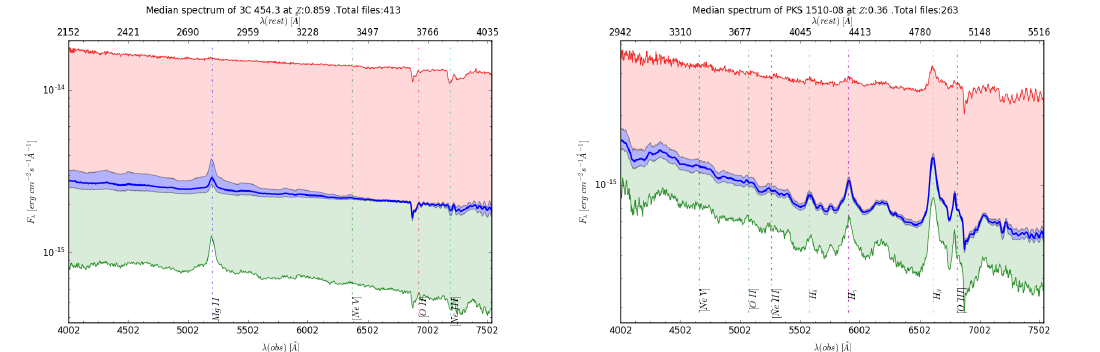
Figure 1. Median spectra computed for two FSRQ type objects: 3C 454.3 and PKS 1510-08. The median spectrum is shown as the dark blue line, red and green lines represent the spectra at the maximum and minimum levels of activity. The light blue area indicates the spectral shape variation within the first and third quartiles. The features observed around 6900 Å and 7200 Å are due to uncorrected telluric absorption. There is also clear fringing at wavelengths redder than 6900 Å, due to the use of a thinned CCD.